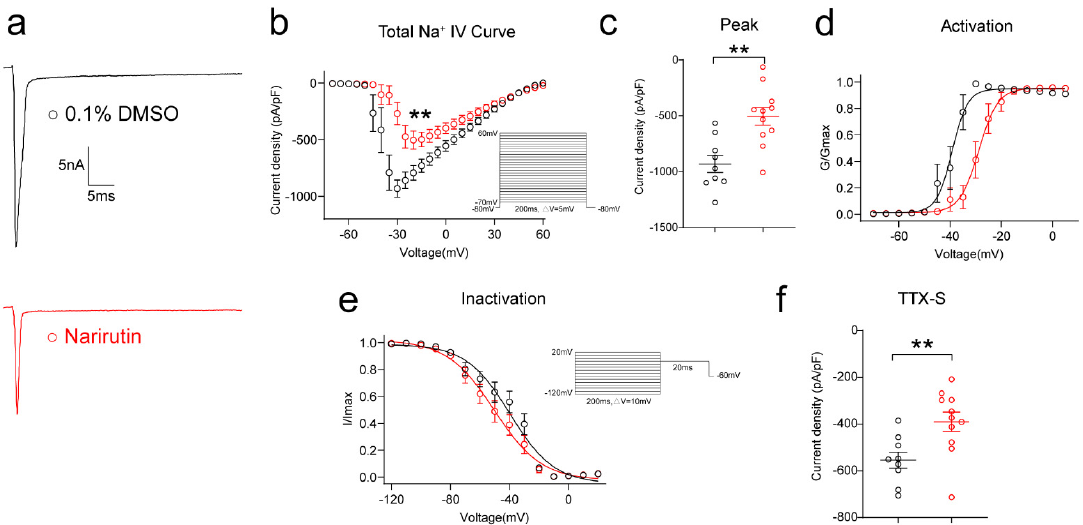
Table 1. Similarly, steady-state inactivation properties of sodium currents were compared between the conditions (Figure 3e). These results show that Narirutin shifted both the V 1/2 activation (left-shifted) and inactivation (right-shifted) of Na V channels (see Table 1).